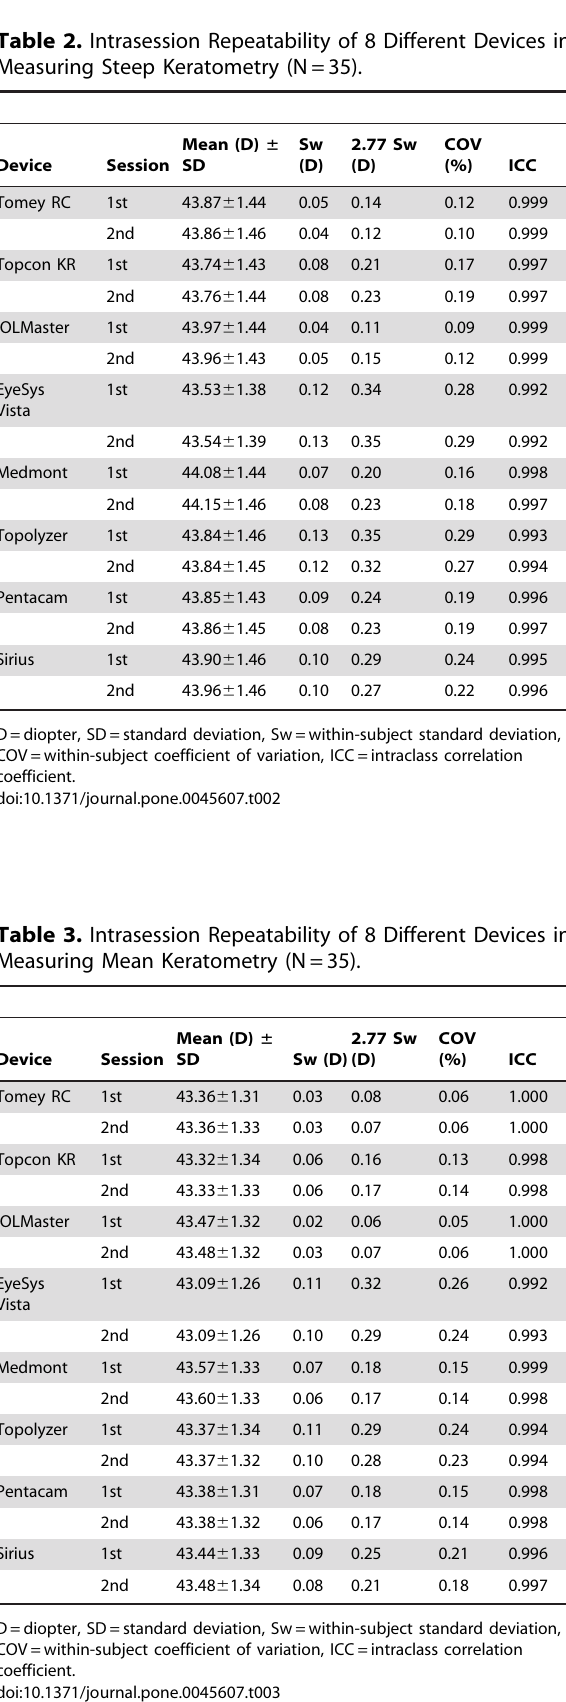
Table 5: the 95% LoAs were equal or smaller than 0.5D for almost instruments, except for EyeSys and Medmont. Among these paired comparisons, the largest 95% LoA were obtained for the EyeSys-Medmont comparison ( 2 0.88 to 2 0.22 D).